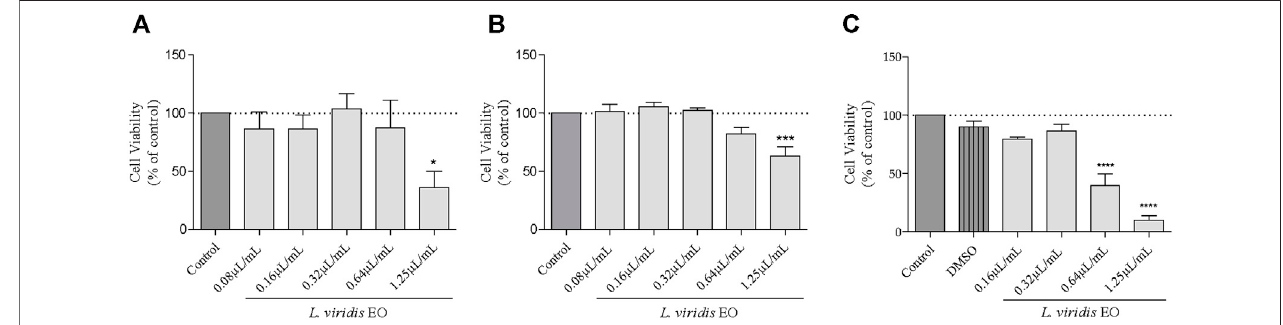
FIGURE 1 | Effect of L. viridis L´Hér. essential oil (EO) on human cell lines viability: (A) HepG2, (B) A549 and (C) HaCAT. Cells were treated with different concentrations of the essential oil for 24 h (A, B, C) or DMSO (C) . Cell viability is expressed as a percentage of MTT reduction in comparison to control cells (100% viability). Each value represents the mean ± SEM from three experiments, performed in duplicate. Statistical differences between groups were calculated by one-way ANOVA followed by Dunnet ’ s post hoc test (* p < 0.05, *** p < 0.001, **** p < 0.0001, compared to control).